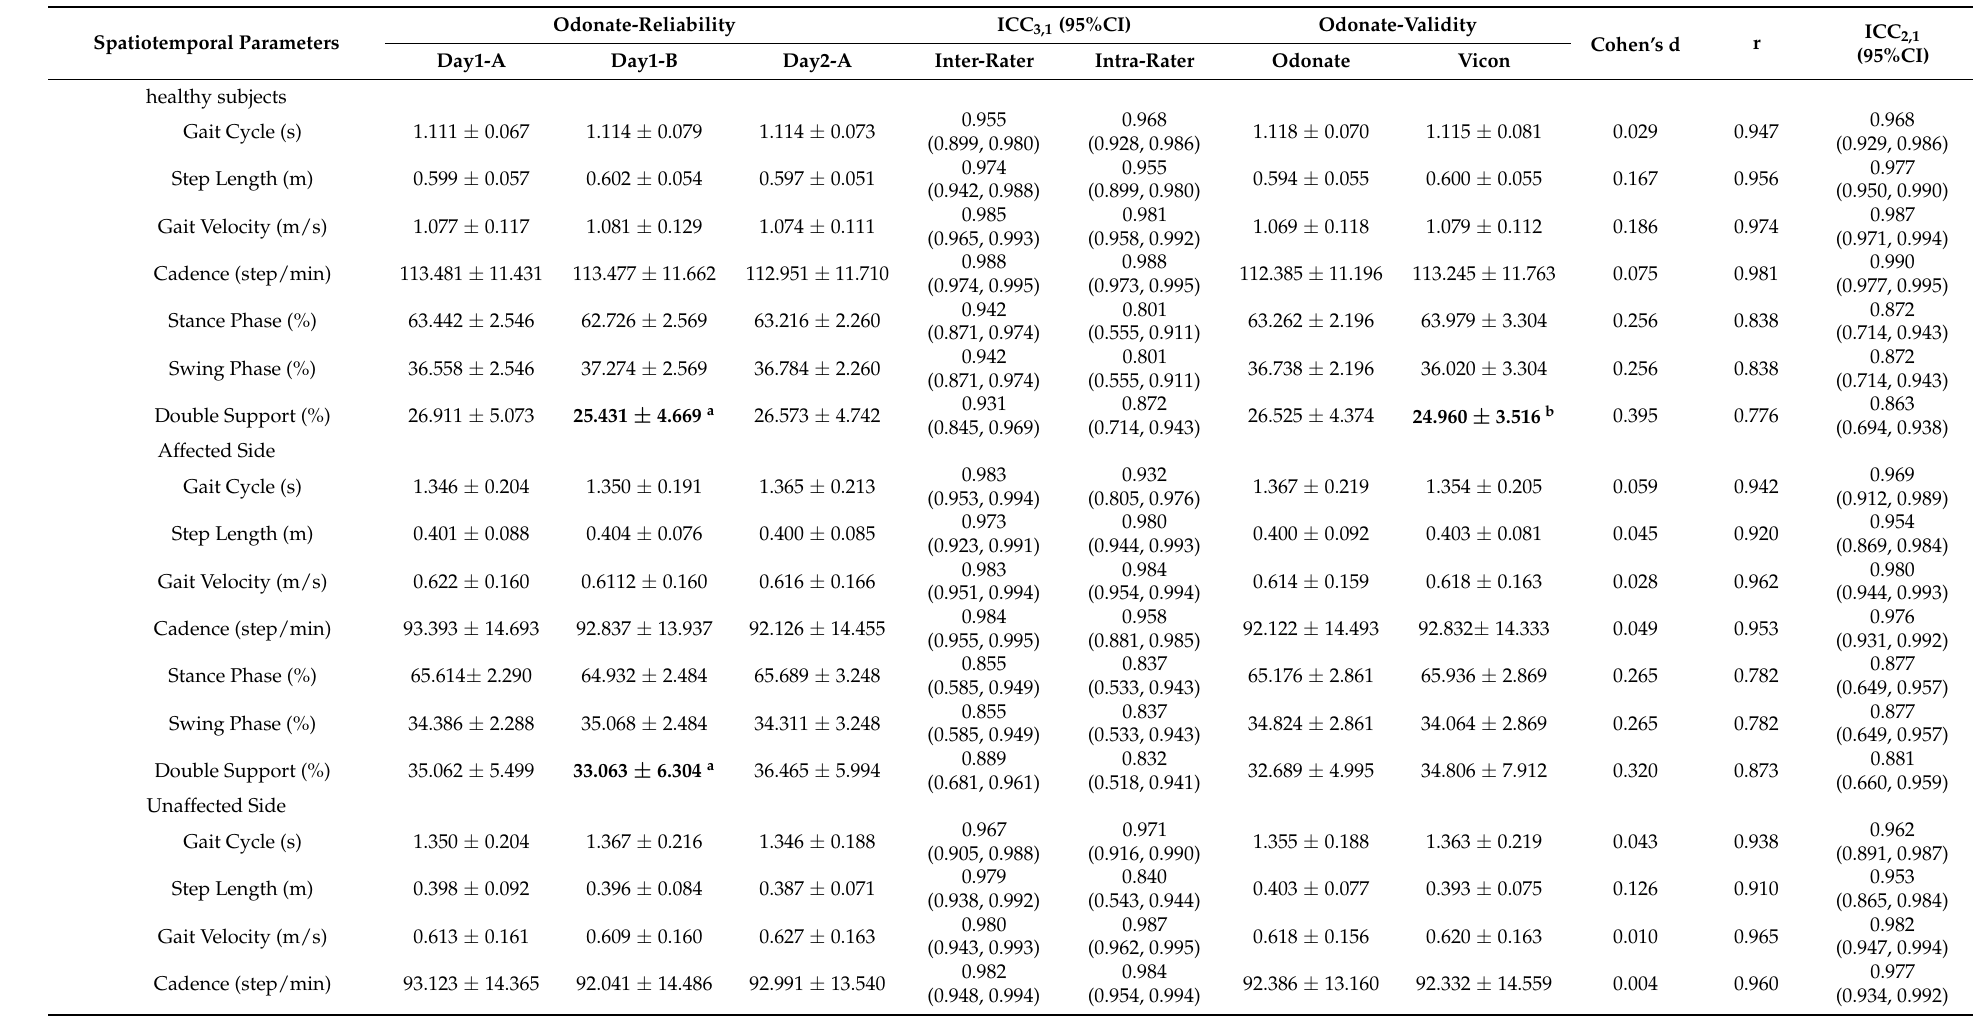
Table 1. Mean, standard deviation, and the results of consistency analysis of spatiotemporal